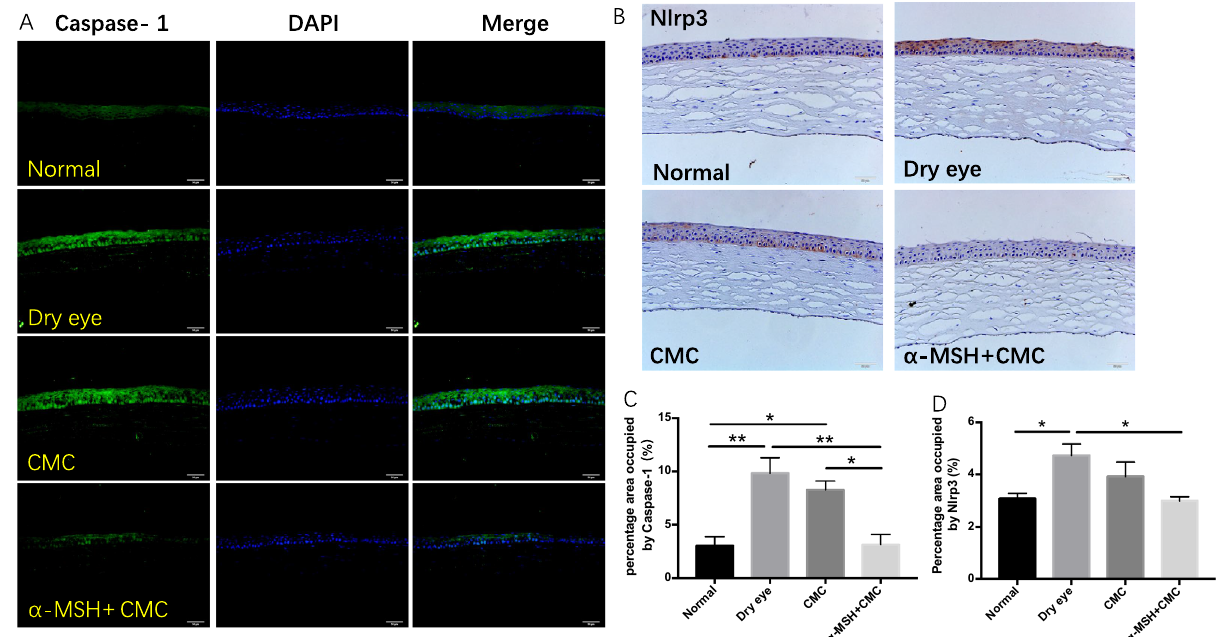
Figure 3. Combined CMC + α-MSH treatment reduced Nlrp3 and Caspase-1 expression levels in rats with scopolamine-induced dry eye. Rats were divided into normal, dry eye, CMC, and CMC + α-MSH groups. The Caspase-1 expression was examined by immunofluorescence staining. Representative images of immunofluorescence staining are shown ( A ). The expression level was quantified (n = 5, C ). The Nlrp3 expression was examined by immunohistochemistry. Representative images of immunohistochemistry are shown ( B ) The expression level was quantified (n = 6, D ). Data are shown as mean ± SEM. * p < 0.05; ** p < 0.01; *** p <